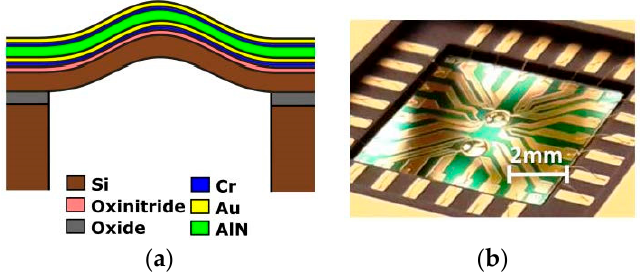
Figure 2 . (a) The conceptual design of the piezoelectric bistable membrane using a silicon membrane with AlN as piezoelectric layer sandwiched between top and bottom electrodes; ( b ) shows a bonded die with 2 membranes having multiple contacts to the electrodes.